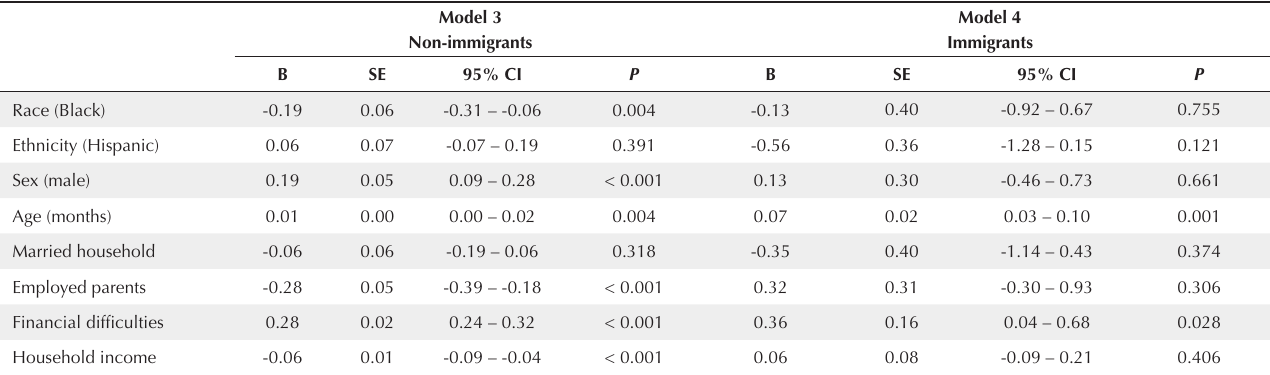
Table 3. Summary of Linear Regressions by Immigration Status (n =